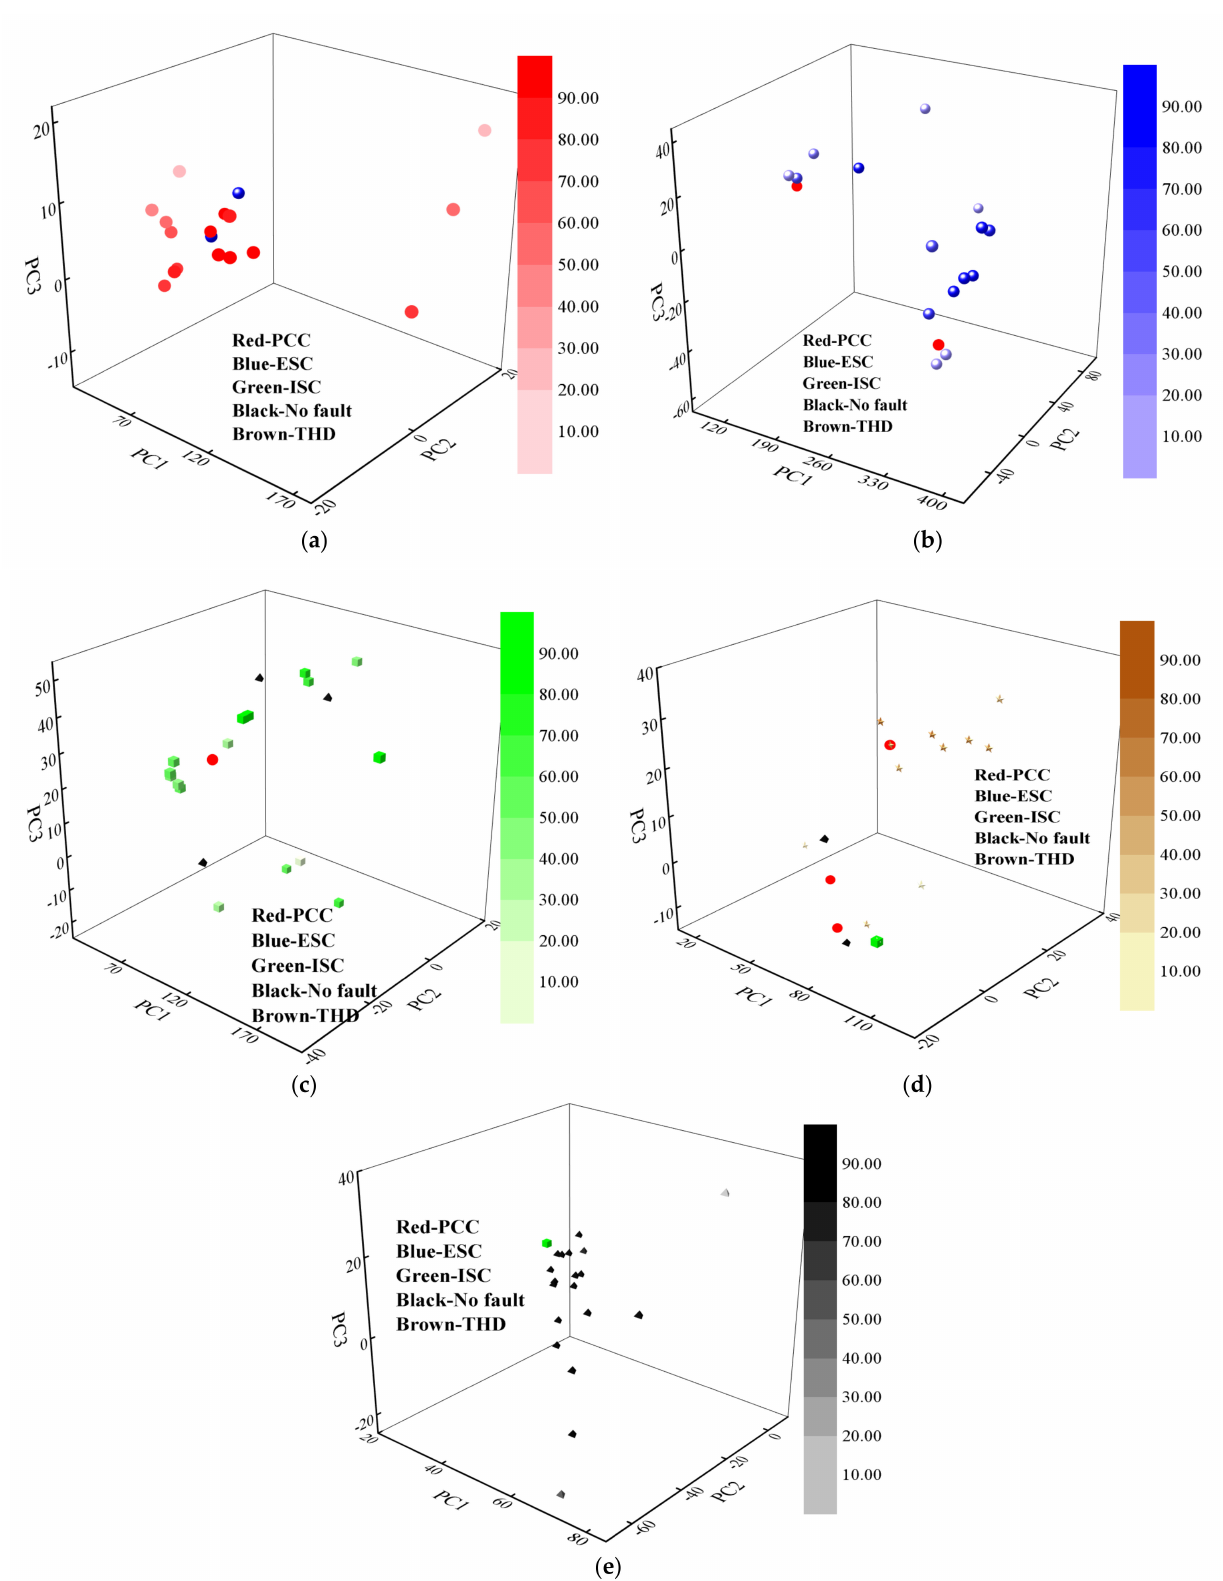
Figure 6. Fault isolation performance based on mRVM: ( a ) PCC; ( b ) ESC; ( c ) ISC; ( d ) THD; ( e ) No